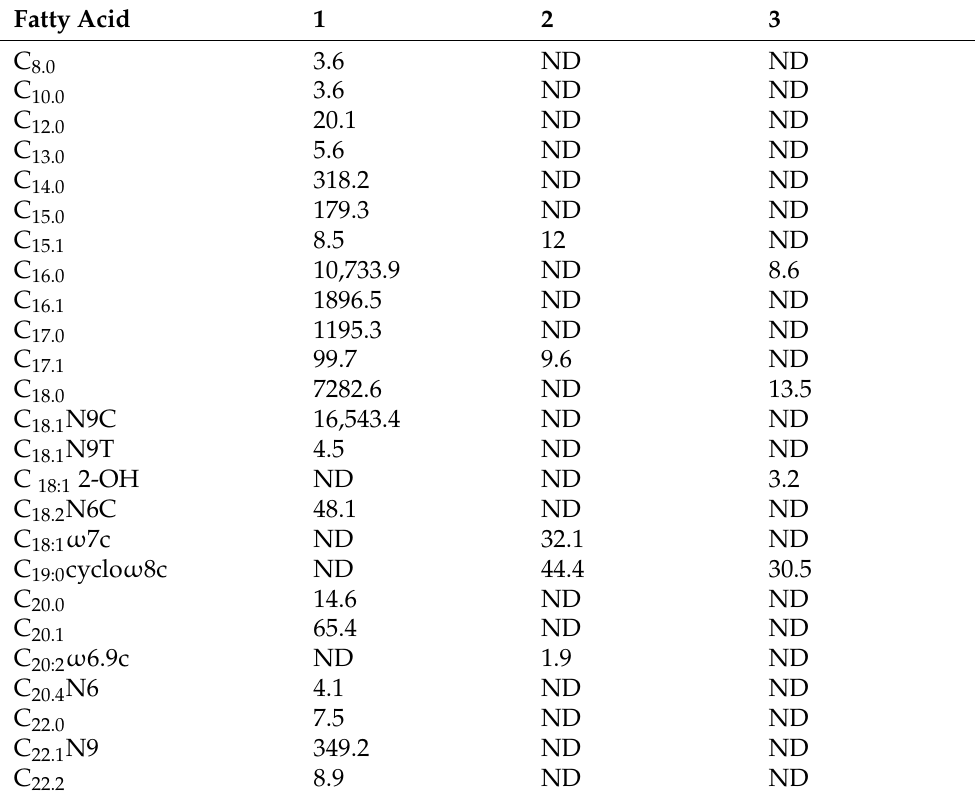
Table 4. Cellular fatty acid profiles of strain TDYN1 and its relatives. Strains: 1, TDYN1; 2, Fal- sochrobactrum ovis B1315 T [28]; 3, Falsochrobactrum shanghainese HN4 T [27]; ND, no data. The results of TDYN1 were from this study, other data were from the references.